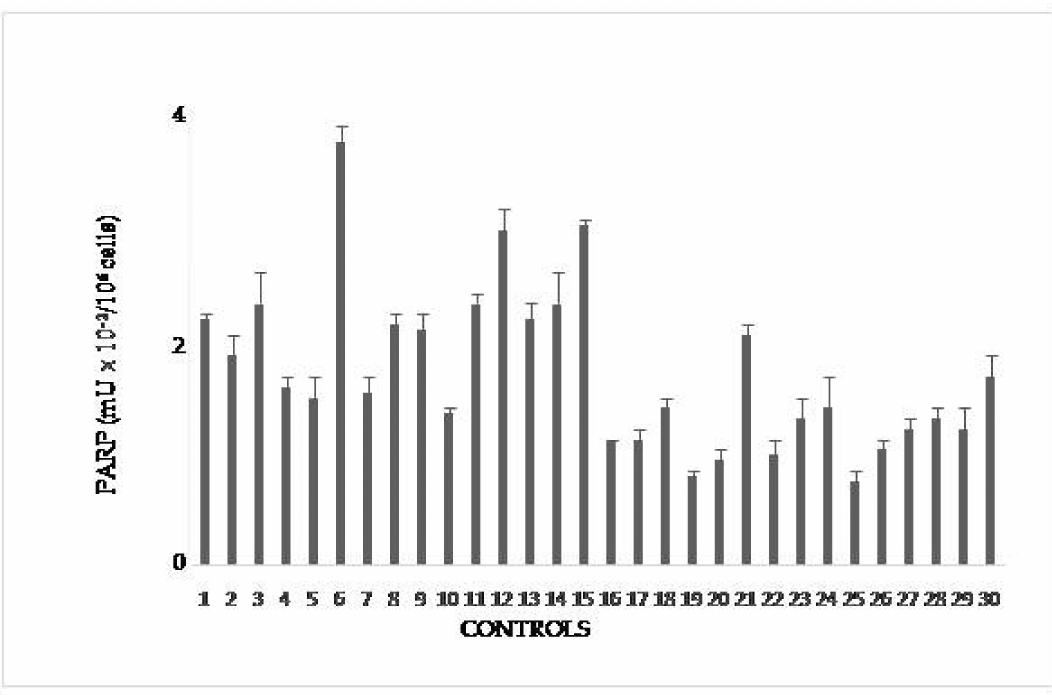
Figure 1. PARP activity in lymphocytes from blood donors. The values are mean averages of duplicate measures from two different lysate preparations (20 µ g proteins per each